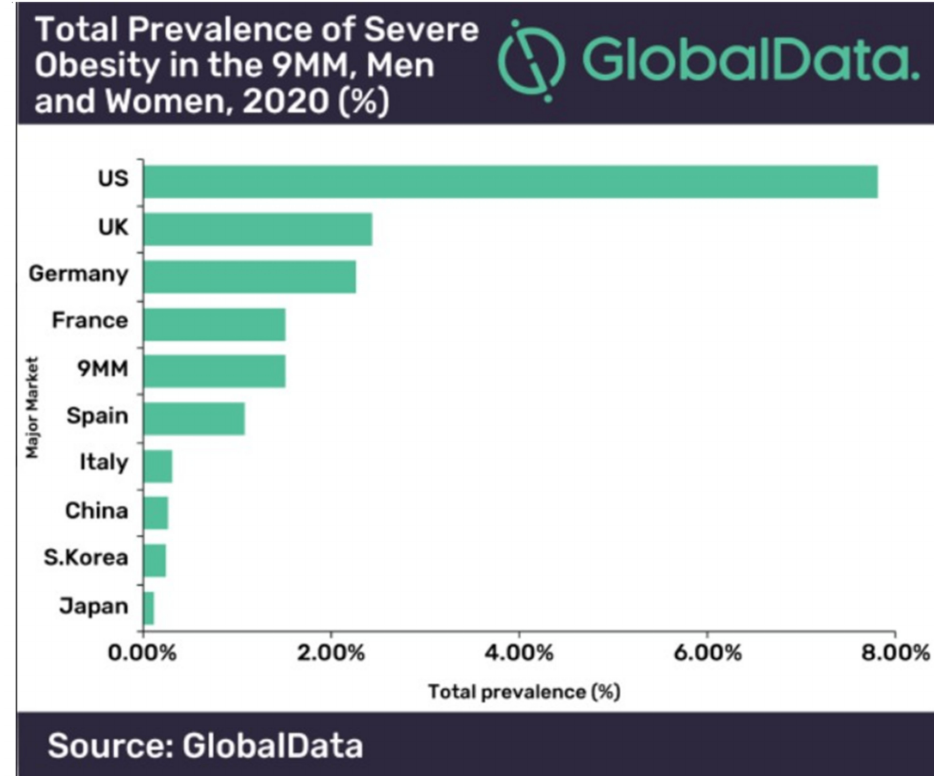
Figure 11. People overweight in USA and Europe (by the courtesy of